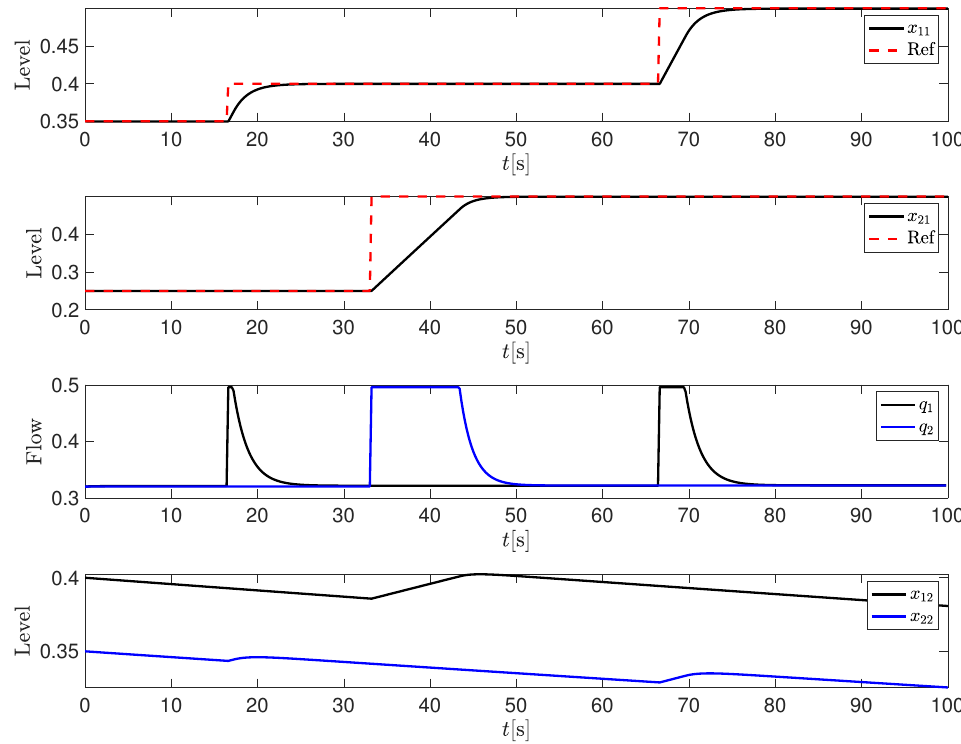
Figure 8. Level control of the four-tank